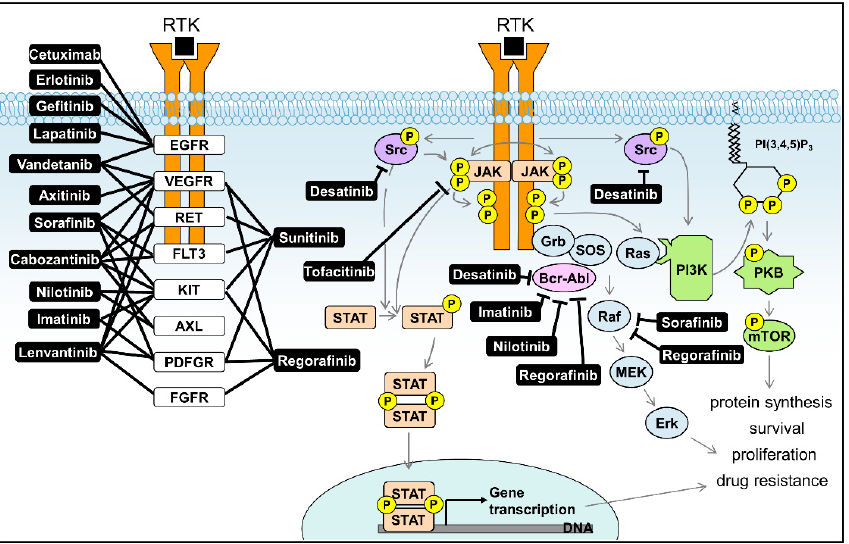
Figure 7. Common signaling pathways in liver disease (primarily HCC) and the kinase inhibitors aimed at these pathways. Receptor tyrosine kinase (RTK) inhibitors are the main group of kinase inhibitors currently used in clinical practice. Most RTKs activate common downstream pathways: the JAK/STAT pathway, the mitogenic Ras/Raf/MEK/ERK pathway, and the PI3K/PKB survival pathway. These pathways show considerable overlap, with Src activating several of their members, and the guanine nucleotide exchange factor SOS being a target for both the adaptor protein Grb (activated via RTKs) and the oncogene Bcr-Abl (Figure based on [69,123]).